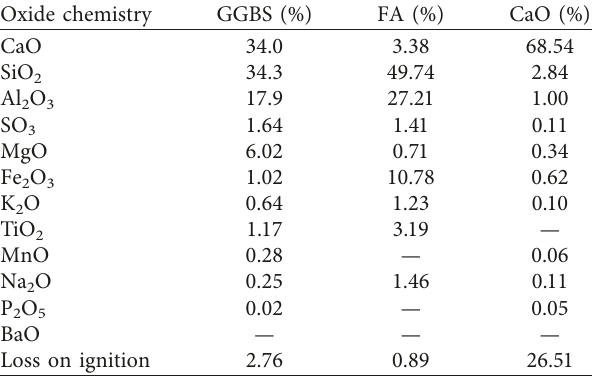
Table 1: Chemical properties of materials used in this